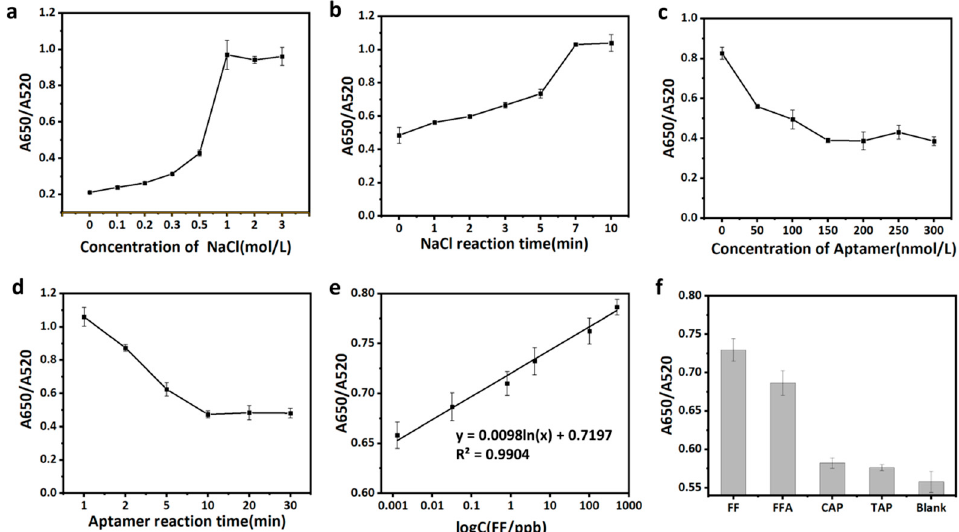
Figure 4. Optimization of AuNPs colorimetric conditions: ( a ) Optimization of NaCl concentration. ( b ) Optimization of NaCl reaction time. ( c ) Optimization of aptamer concentration. ( d ) Optimization of reaction time between aptamer and AuNPs. ( e ) The linear relationship between absorbance and the concentration of FF in standard solution. A650 is the absorbance value at 650 nm and A520 is the absorbance value at 520 nm. ( f ) Relative fluorescence intensity of Apt-14t in the presence of florfenicol, florfenicol amine, chloramphenicol, and thiamphenicol.